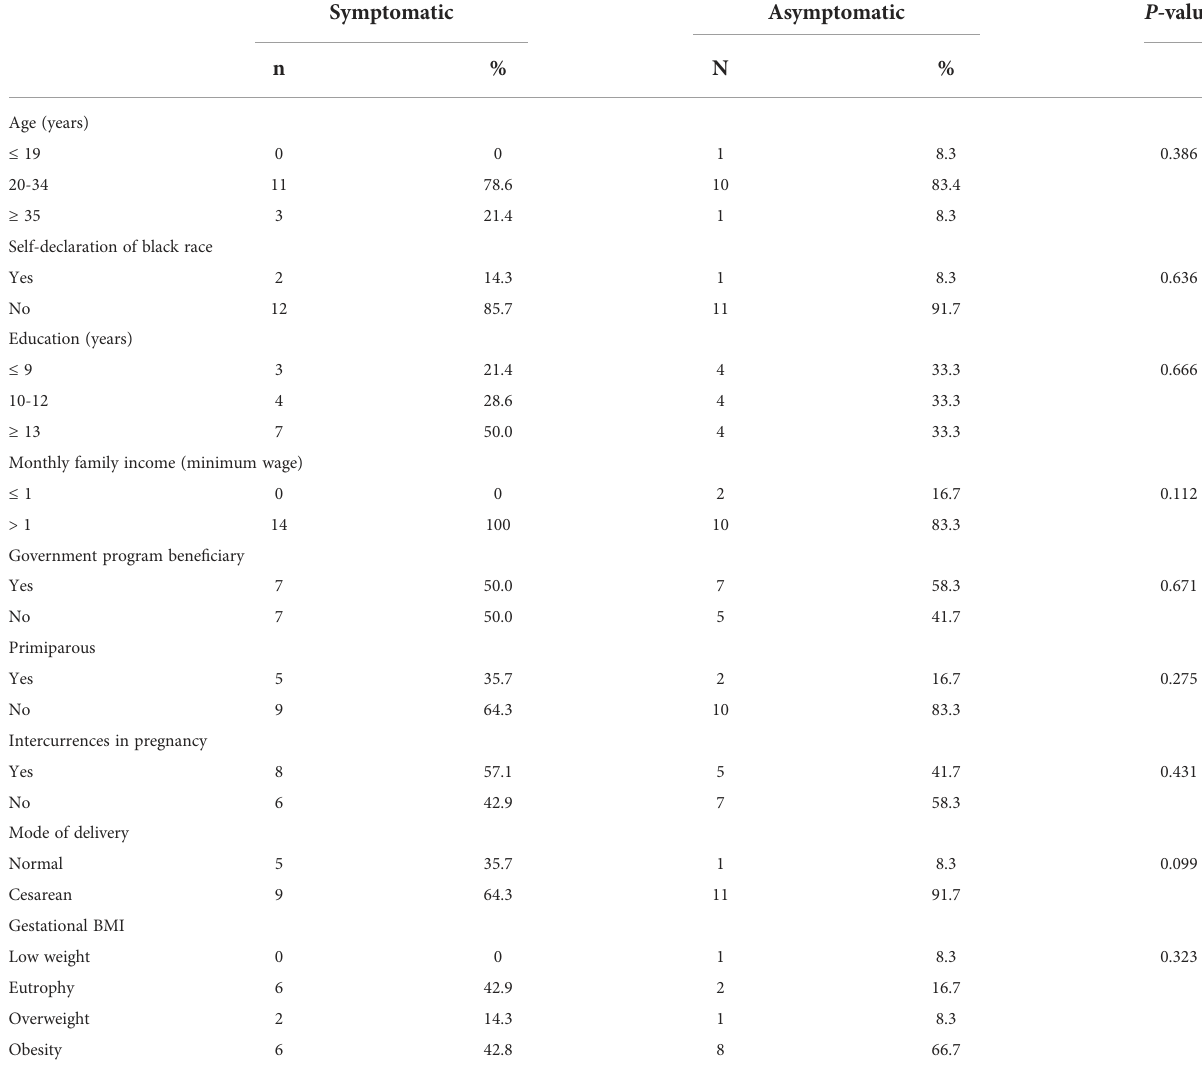
TABLE 2 Demographic, socioeconomic, obstetric and nutritional status characteristics of symptomatic (n=14) and asymptomatic (n=12) for Covid-19 of lactating women, during pregnancy. Symptomatic